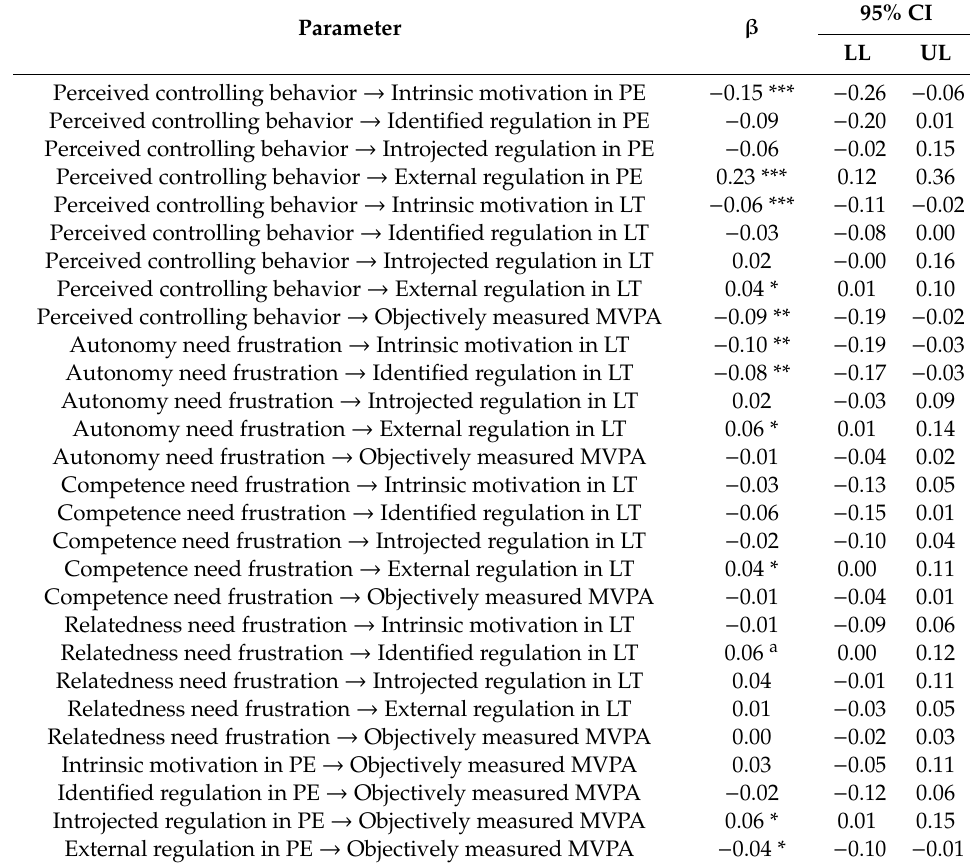
Table 2. Standardized parameter estimates of indirect e ff